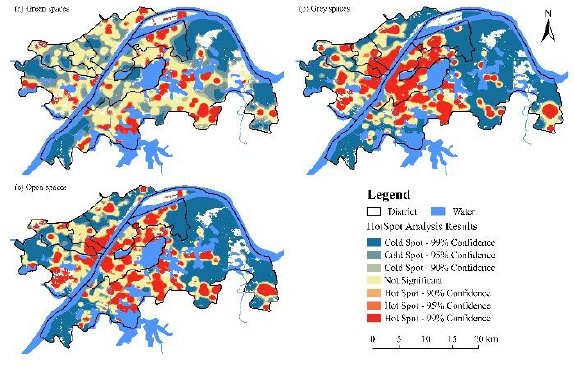
Figure 6 . Study area hotspot analysis